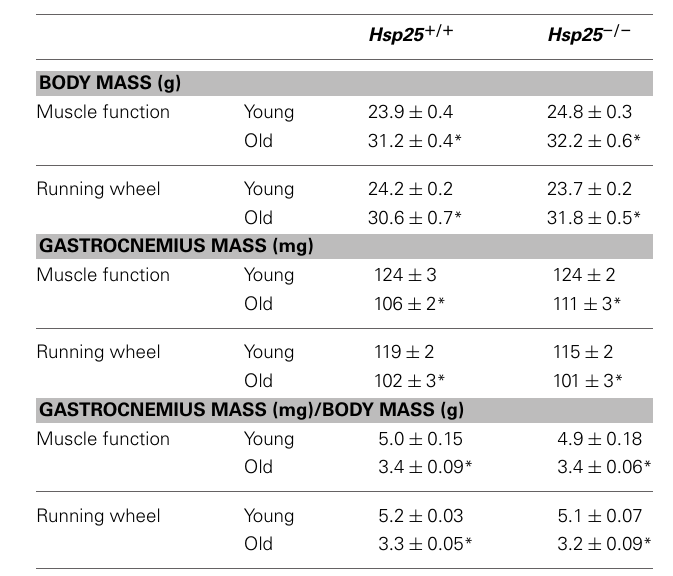
Table 1 | Final body mass, muscle mass, and muscle mass normalized to body mass for young and old Hsp 25 + / + and Hsp 25 − / − mice in muscle function and running wheel groups.